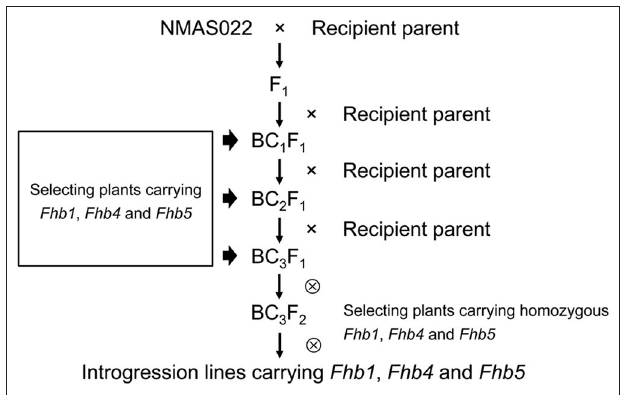
FIGURE 2 | Scheme for Fhb1 , Fhb4 , and Fhb5 pyramiding.